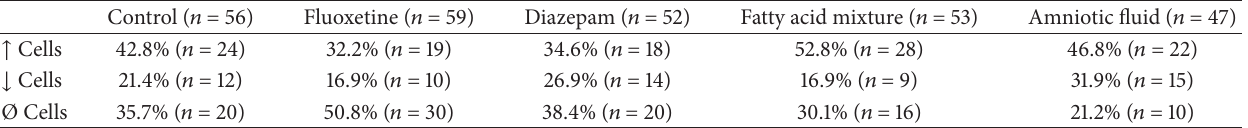
Table 1: Lateral septal neuron distribution according to type of response to electrical stimulation of the medial amygdala.